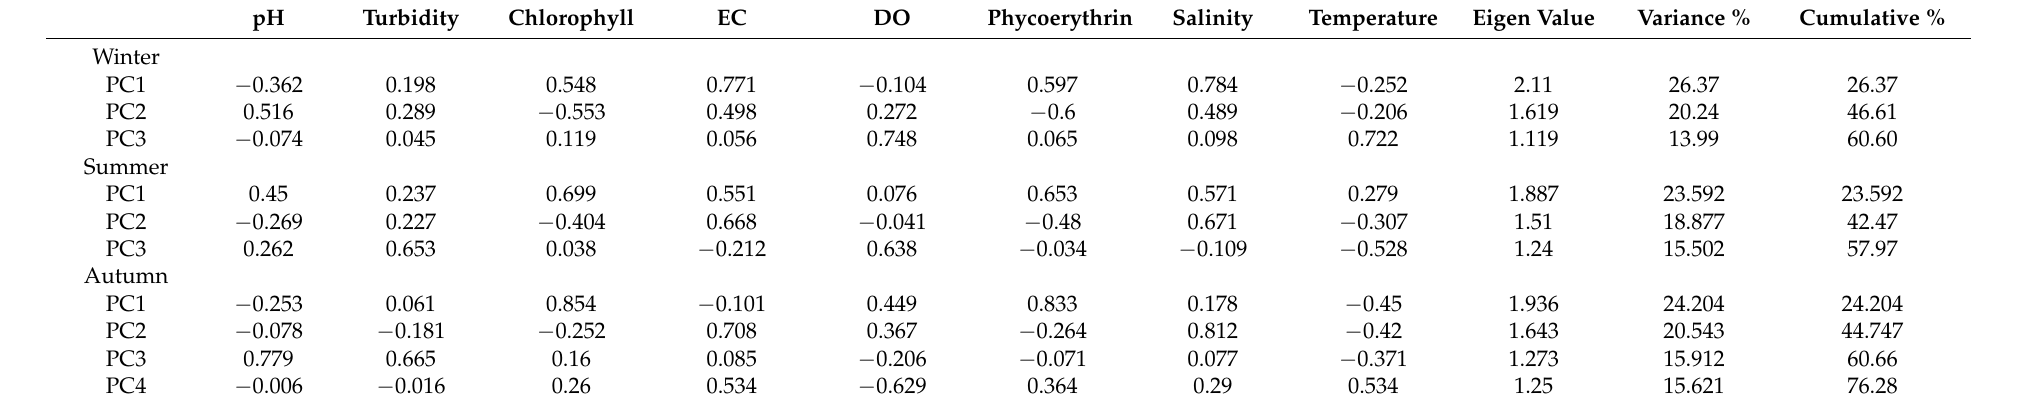
Table 5. Loadings of experimental variables (eight) on significant principal components for winter, summer, and